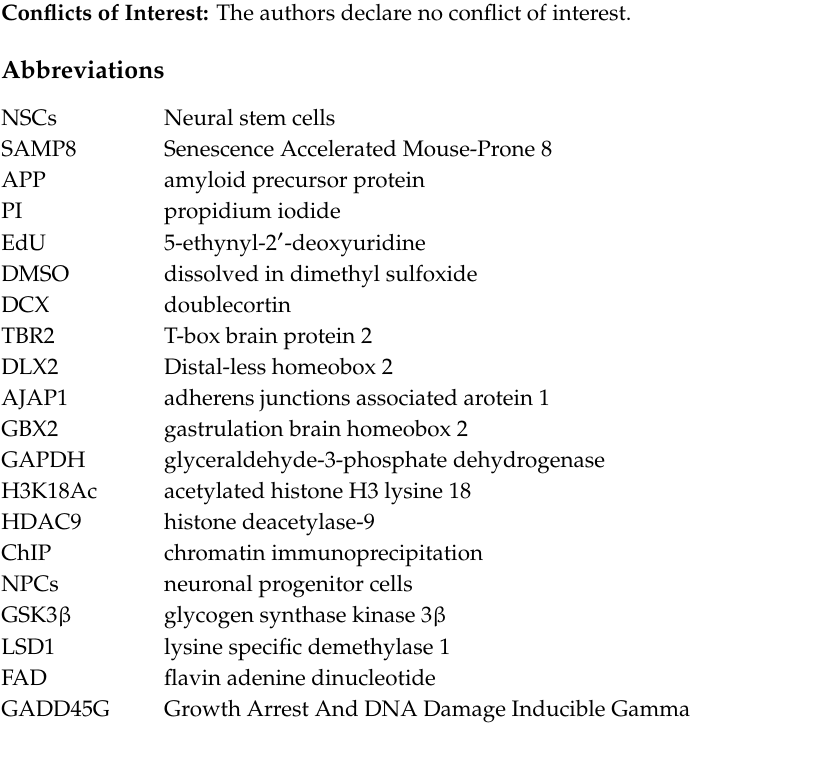
List of di ff erentially expressed genes. Table S3. Primary and secondary antibody specifications. Table S4. List of gene specific primers for qRT-PCR. Table S5. List of gene specific primers for ChIP